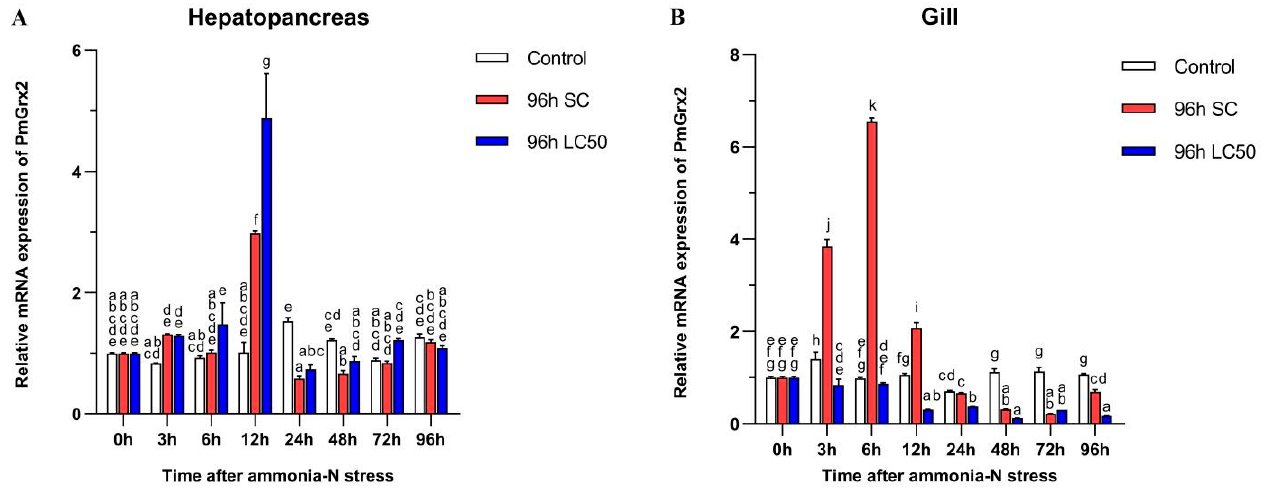
Figure 4. mRNA expression levels of PmGrx2 in the hepatopancreas ( A ) and gill ( B ) at different time intervals, under different concentrations of ammonia-N stress. The data are presented as mean ± SD (n = 3). Different letters are used to show significant differences ( p < 0.05).